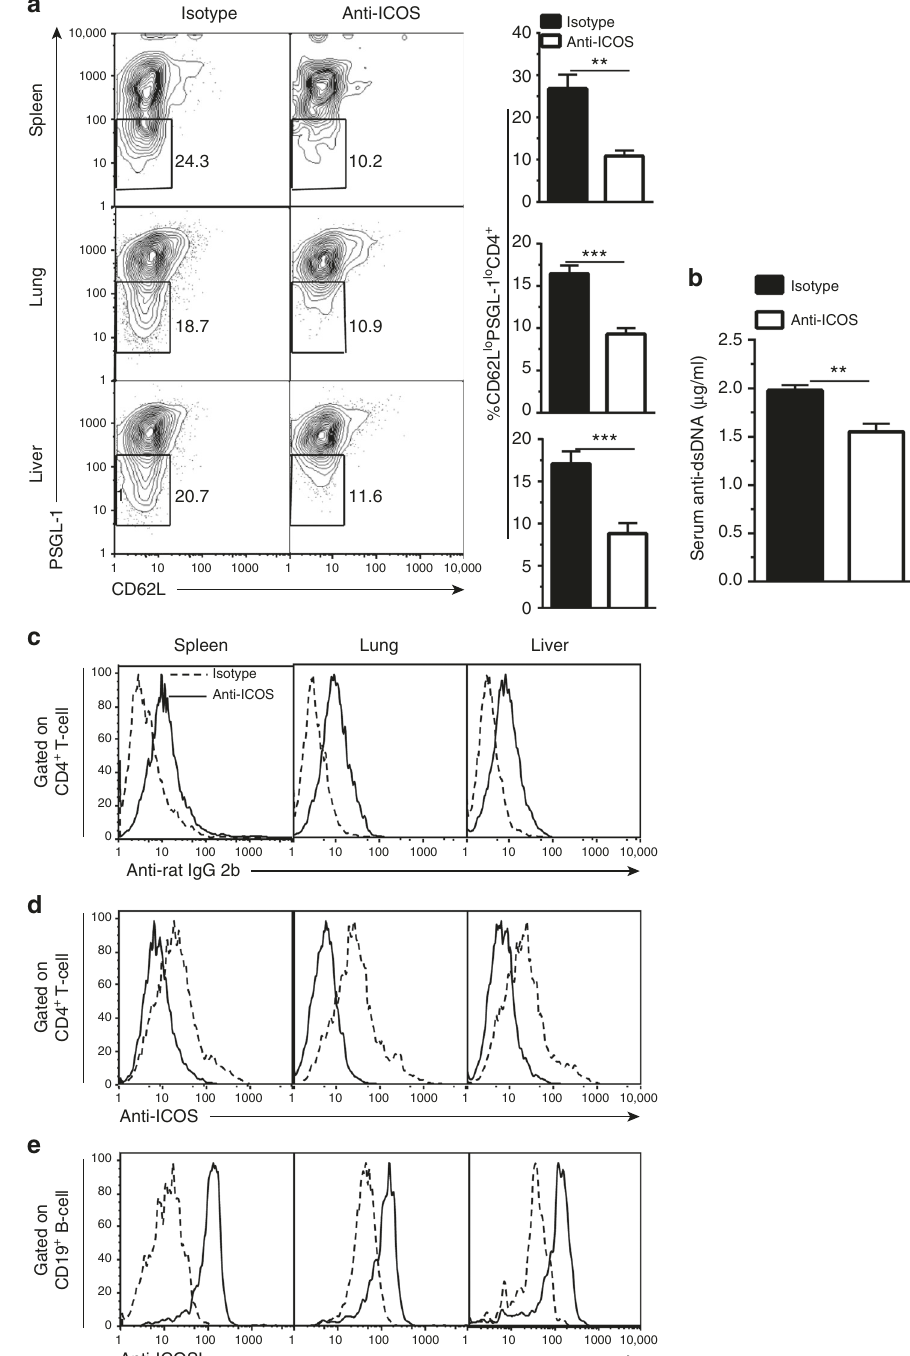
Fig. 5 Anti-ICOS treatment reduces PSGL-1 lo CD4 + T-cell expansion. As described in Fig. 4, BALB/c recipients were irradiated (850 cGy) and given 2.5 × 10 6 TCD-BM plus 1 × 10 6 splenocytes. Recipients were treated with anti-ICOS or control rat IgG2b (200 µ g/mouse i.p.) every other day from day 0 to day 45 after HCT. a Twenty-one days after HCT, mononuclear cells from spleen, lung, and liver were stained for CD4, CD44, PSGL-1, and CD62L. Gated CD4 + CD44 hi cells are shown as PSGL-1 versus CD62L ( n = 8). b Serum anti-dsDNA was measured at 45 days after HCT. c – e Twenty-one days after HCT, mononuclear cells from spleen, lung, and liver were stained with CD4, anti-rat IgG2b, or anti-ICOS, or stained with anti-CD19 and anti-ICOSL. Gated CD4 + T cells are shown as anti-rat IgG2b ( c ) or anti-ICOS ( d ) staining. e Gated CD19 + B cells are shown as ICOSL staining. One representative of four experiments is shown. ** P < 0.01, *** P < 0.001, unpaired two-tailed Student ’ s t